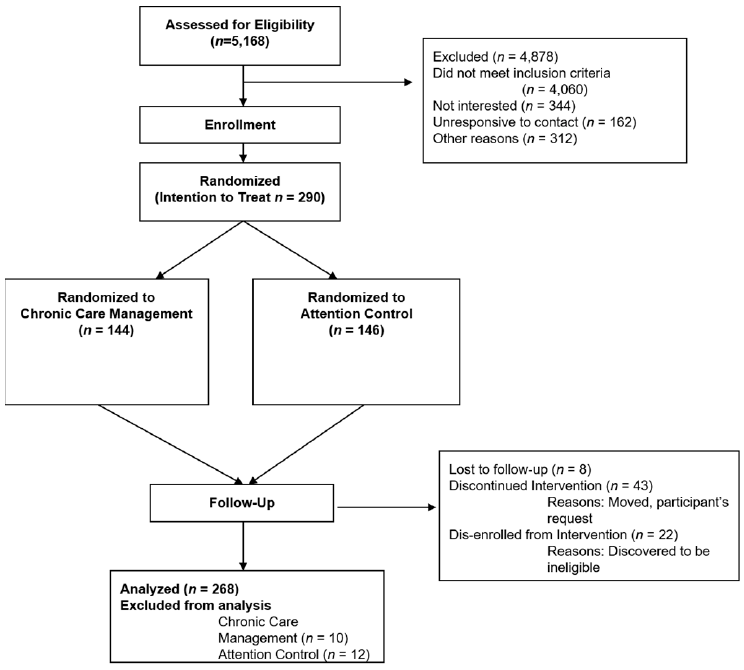
Figure 1. CONSORT diagram of Chronic Care Management randomized controlled trial.